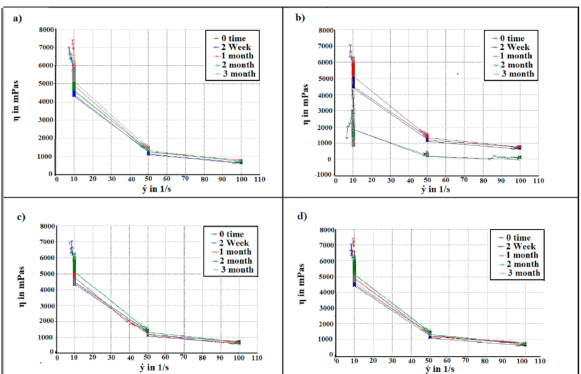
Figure 6. The flow curve of paracetamol instant jelly samples stored in packaging 1 under ( a ) real- time conditions and ( b ) accelerated conditions and samples stored in packaging 2 under ( c ) real-time conditions and ( d ) accelerated conditions at different time points (0, 2 weeks, 1, 2, and 3